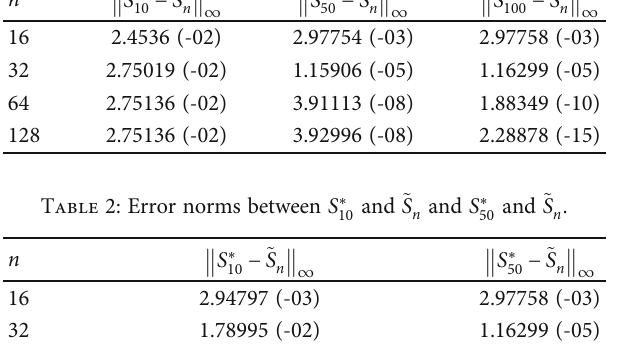
Table 1: Error norms between S ~